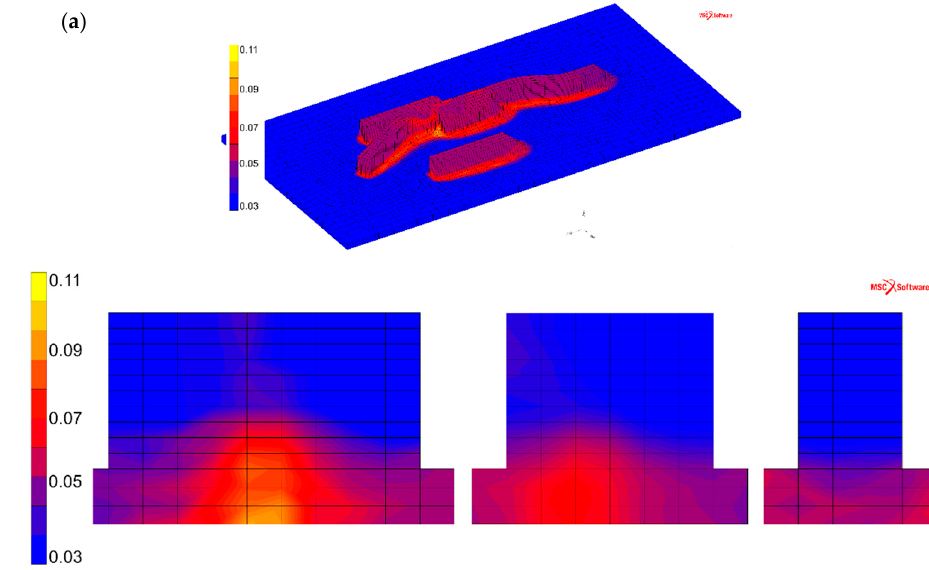
Figure 10. Simulated α gb phase fraction after wire feed additive manufacturing. ( a ) Complete view of the sample. ( b ) Cross-sections of one, two, and three weld-beads-wide